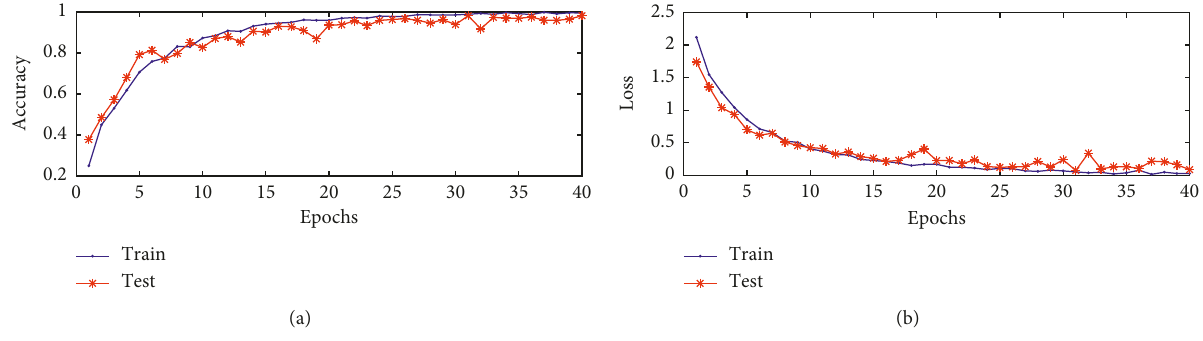
Figure 5: Training and testing curve for accuracy and loss.